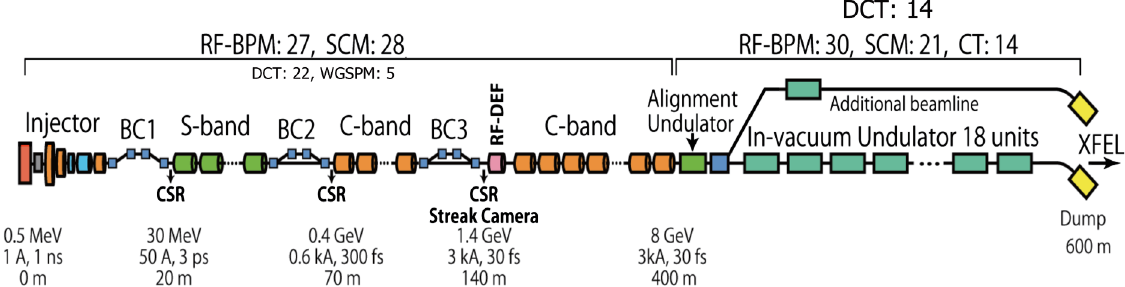
FIG. 1. SACLA machine layout and beam